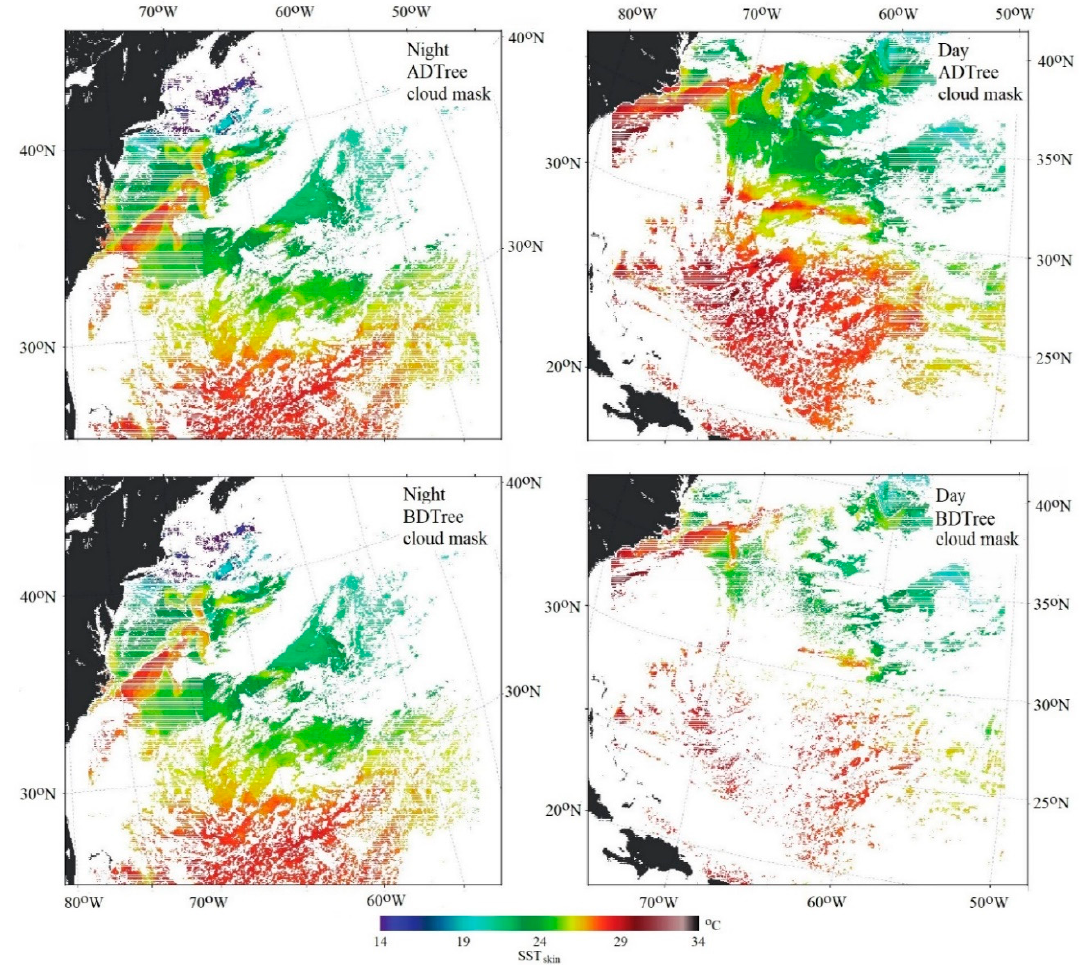
Figure 7. Improvements in the coverage of VIIRS SST skin retrievals resulting from the adoption of the Alternating Decision Tree (ADTree) cloud screening compared ( top ) to the prior Binary Decision Tree (BDTree) approach ( bottom ). An example of nighttime coverage is at left, and during the day at right. The images are a full swath, the edges of which can be seen at the vertical edges of the images.